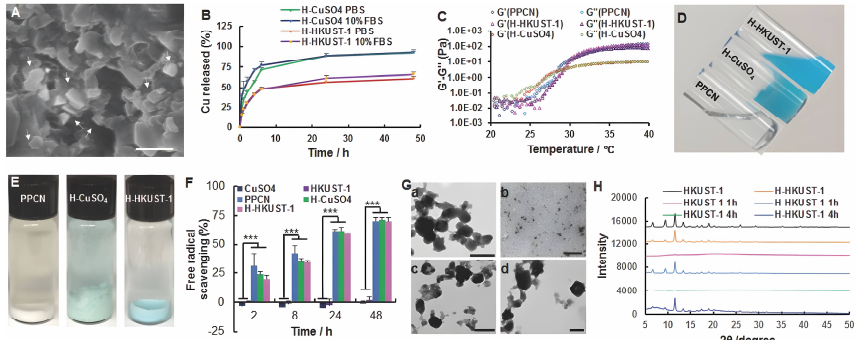
Figure 8. Characterization of H-HKUST-1. ( A ) SEM digital image of H-HKUST-1. White arrows point to HKUST-1 NPs. (Scale bar: 500 nm). ( B ) Copper release from H-HKUST-1 and H-CuSO 4 in PBS or 10% FBS. ( C ) Rheological characterization of PPCN, H-HKUST-1, and H-CuSO 4 . The storage modulus G′ and loss modulus G″ were plotted logarithmically against temperature (20–40 °C at 10 Hz) for the corresponding hydrogel samples. ( D ) Digital images of PPCN, H-CuSO 4 , and H-HKUST-1 at 22 °C. ( E ) Digital images of PPCN, H-CuSO 4 , and H-HKUST-1 after incubation in 10% FBS at 37 °C. ( F ) ABTS radical scavenging capacity of CuSO 4 , HKUST-1 NPs, PPCN, H-CuSO 4 , and H-HKUST-1 (n = 3, *** p < 0.001). ( G ) TEM showing the morphology of ( a , b ) HKUST-1 NPs and ( c , d ) H-HKUST-1 before ( a , c ) and after ( b , d ) incubation in 10% FBS at 37 °C. ( H ) XRD patterns of HKUST-1 NPs and H-HKUST-1 before and after incubation in 10% FBS. Reproduced with permission [203]. Copyright 2017, Advanced Functional Materials